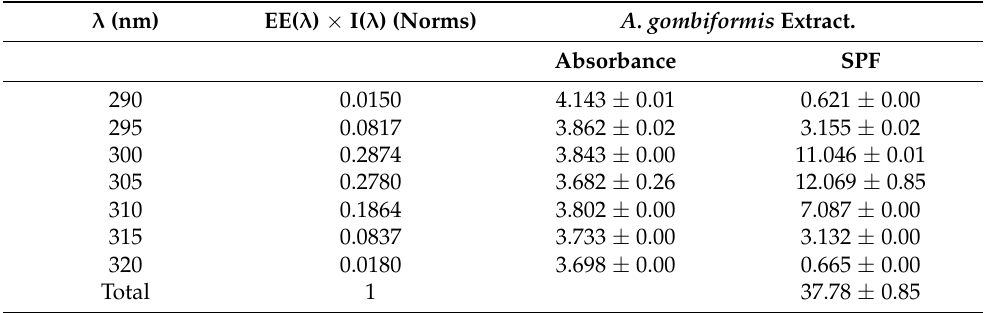
Table 2. Values of sun protection factor of the Astragalus gombiformis extract.